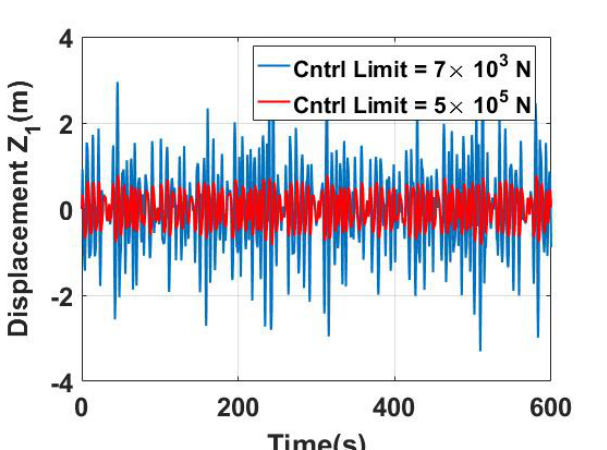
Fig. 11: The displacement of the first mass with a low control limitation and a high control limitation.